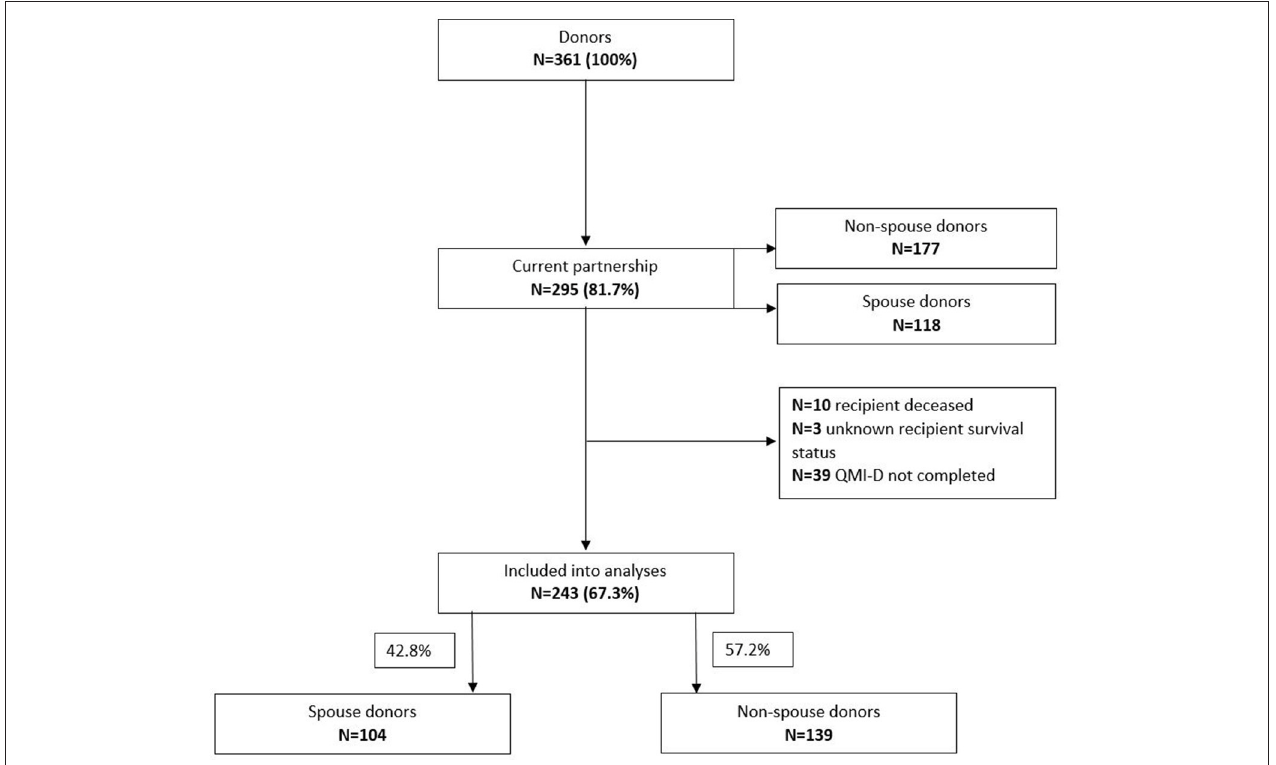
FIGURE 2 | Partnership status in the living donor